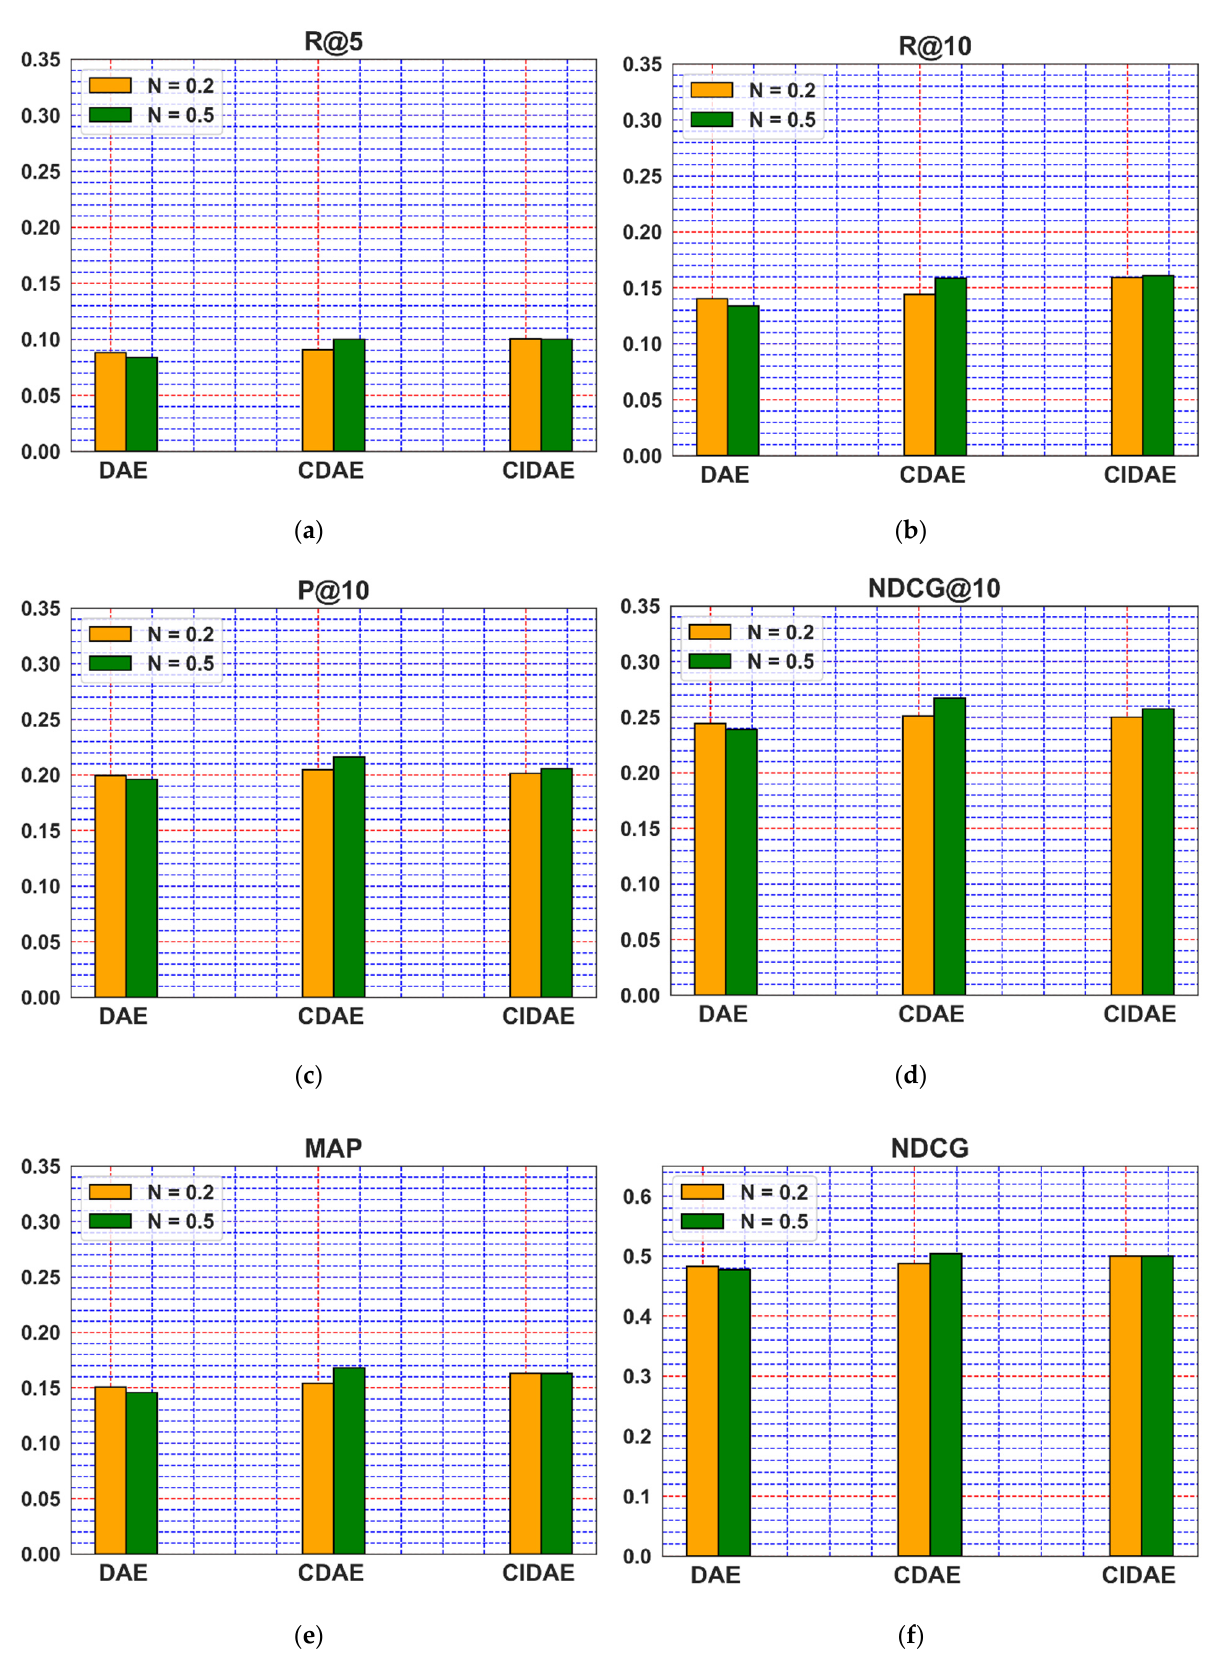
Figure 13. Comparison of ML ‐ 1M for R@5, R@10, P@10, NDCG@10, MAP, and NDCG metrics.